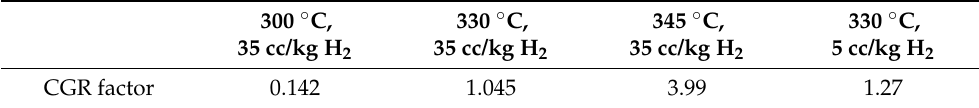
Table 7. Crack growth rate factor for each test condition.